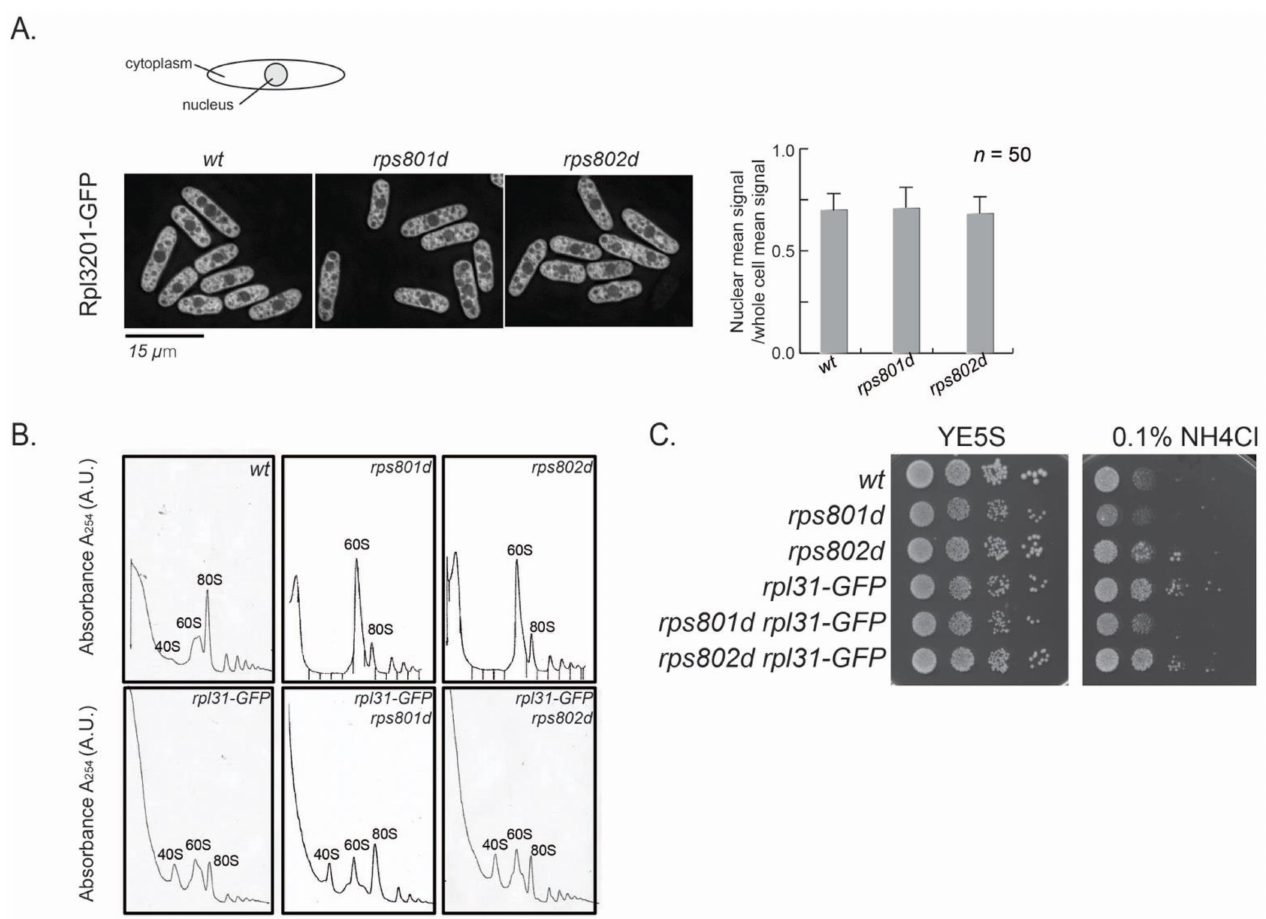
Figure 5. The 60S subunits accumulation is independent of the varied Rpl42/eL42 levels in rps8 par- alogs. ( A ) Rpl3201/eL32 was C − terminally tagged with GFP, and its localization and quantification of the GFP intensity in the nuclei were examined in the wt and rps801d , rps802d . Quantification of the GFP intensity density in the nucleus compared to the whole cell is shown for the experiment presented on the left. Quantification was performed using ImageJ on the maximum projections of the z − sectioning images. A representative image is shown in each case. Error bars represent the SD. ( B ) 60S subunits accumulation is alleviated by the GFP fusion of Rpl31/eL31 in rps8 paralog deletion pairs by the polysome analysis. ( C ) Compromised 60S subunits accumulation is independent of other phenotypes seen in rps8 paralog deletion pairs. The GFP fusion of Rpl31/eL31 did not affect the growth of the rps8 paralog deletion pairs in YE supplied with NH 4